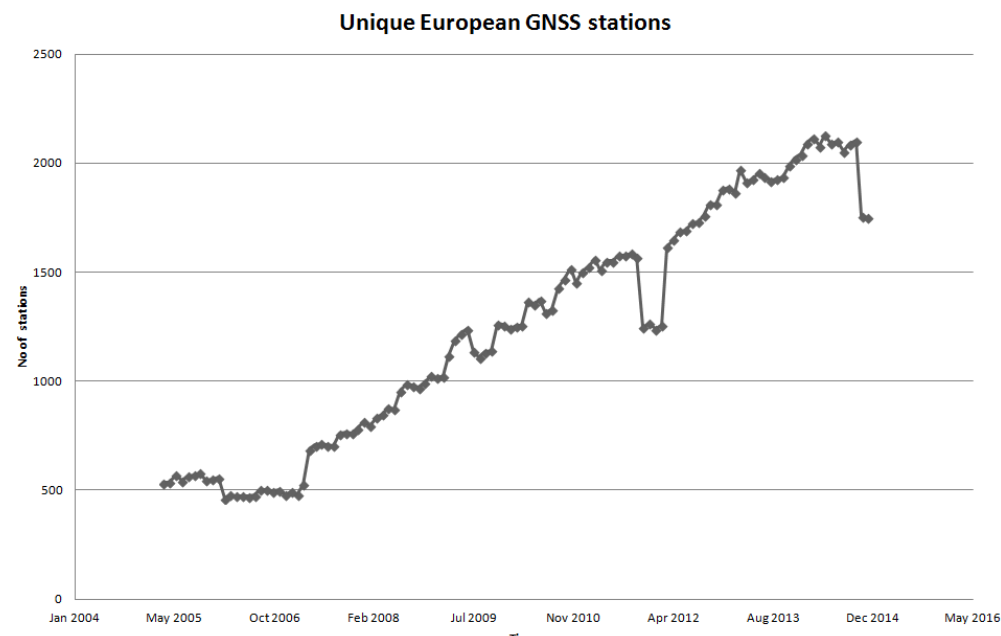
Figure 2. Number of ground-based GNSS stations delivering NRT ZTDs for operational NWP within E-GVAP.